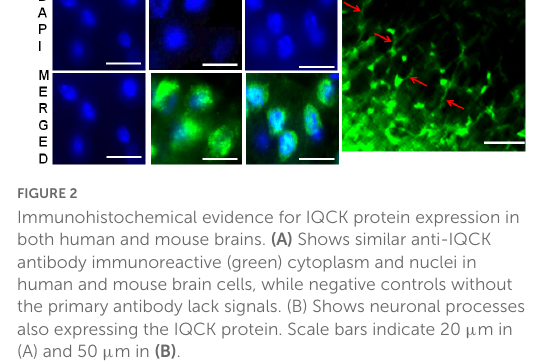
IQCK protein is expressed in neurons. Thus, similar to in vitro results in cell lines, the IQCK protein is expressed in vivo in the brain.